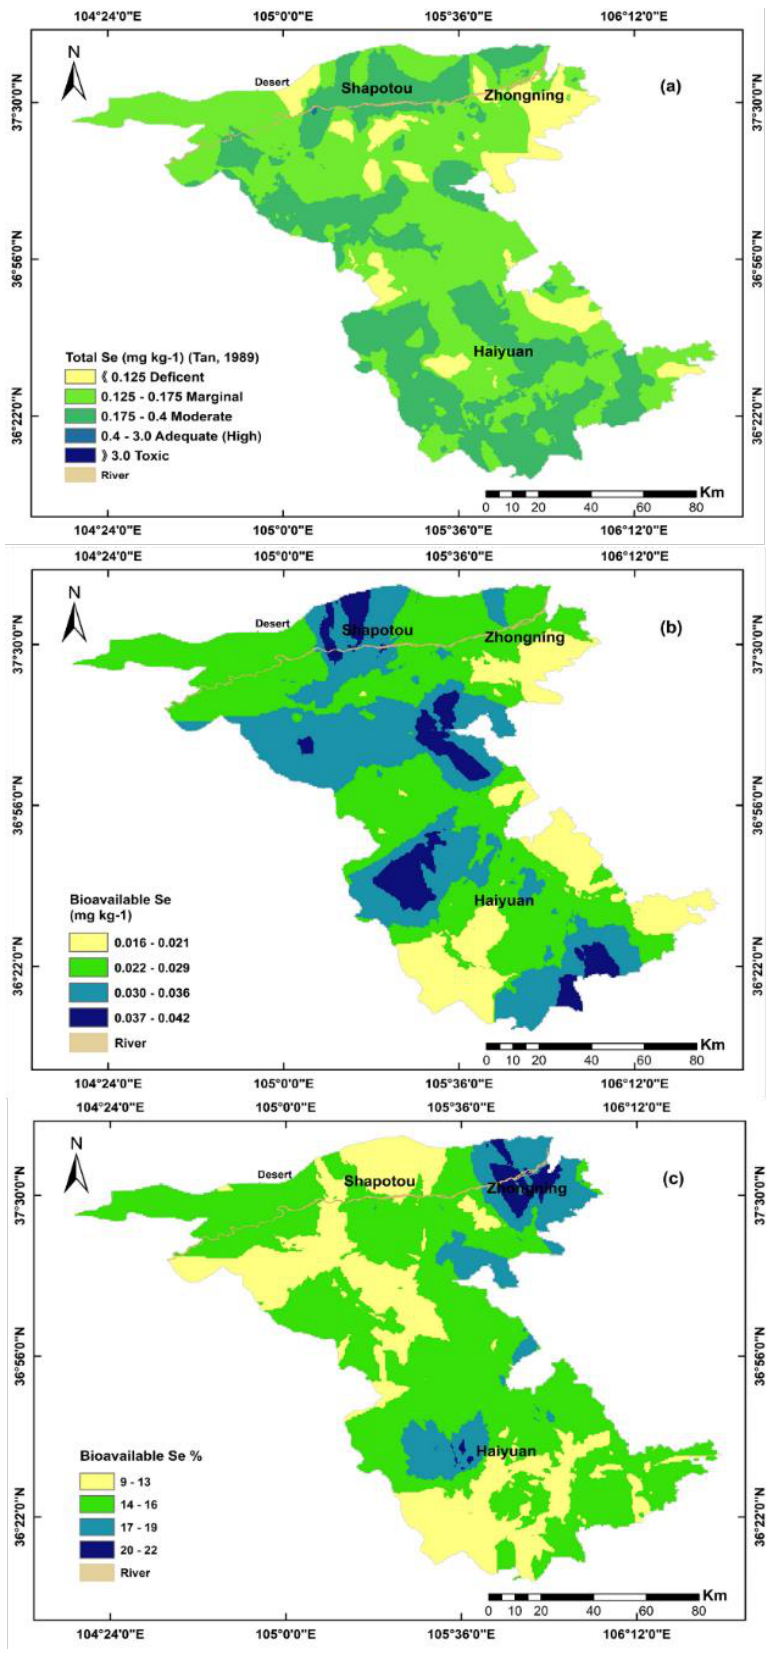
Figure 2. Se distribution in alkaline arable soils of Zhongwei: ( a ) total Se content and classification according to Tan (1989), ( b ) bioavailable Se, ( c ) percentage of bioavailable selenium.